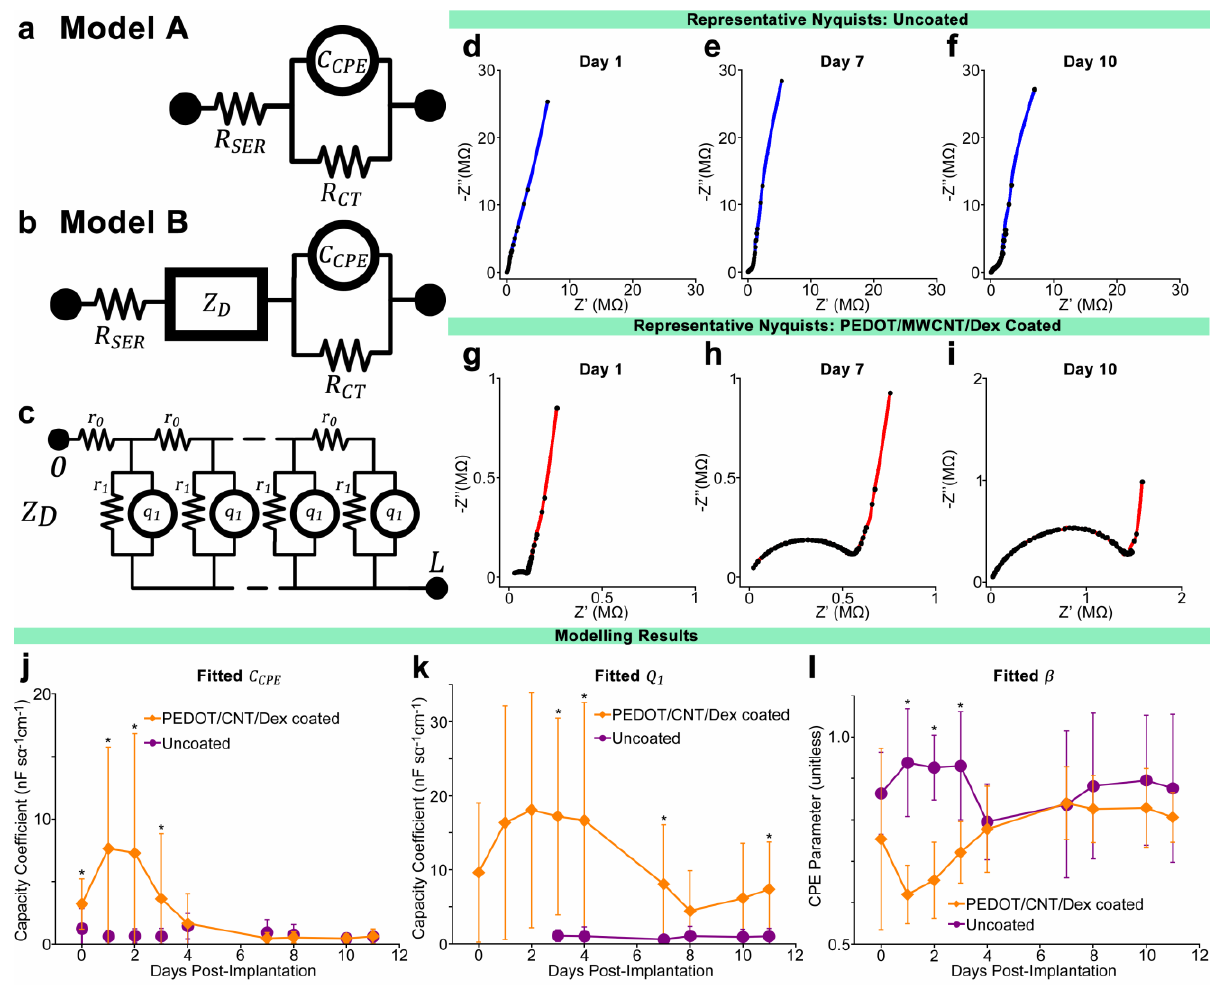
Figure 3. ( a , b ) Equivalent circuit models for uncoated electrodes in PBS or initial days post-implantation (model A) and uncoated electrodes at later days post-implantation as well as PEDOT/MWCNT/Dex-coated electrodes (model B), with distributed element ZD representing the polymer coating as well as tissue encapsulation; ( c ) Schematic of the dual-channel distributed diffusion impedance element ZD; ( d – i ) Representative Nyquist impedance plots of uncoated ( d – f ) and coated ( g – i ) electrodes at three time points post-implantation, with all plots exhibiting an identical frequency range (100 Hz to 33 kHz). Note contrast between uncoated and coated Nyquist plots at days 7 and 10 despite statistically identical 1 kHz impedance. The growing semi-circular features at higher frequencies within ( g – i ) suggest the development of encapsulation over coated electrodes not present in uncoated electrodes; ( j – l ) Average fitted values of modeling parameters CCPE, Q1, and β. Q1 were not fitted for days 0–2 for uncoated probes due to use of model A. Comparatively large values of CCPE during the initial four days indicates a coating benefit to electrode capacitance that diminished at later points. Reducing values of Q1 indicate a reduction in coating/electrolyte capacitance, possibly due to changing surface area. β exhibited low values during first four days, but later increased to values equivalent to uncoated electrodes, suggesting a change to the nature of the coating/electrode interface. N varied from session to session. All data presented as mean ± SD. * p <